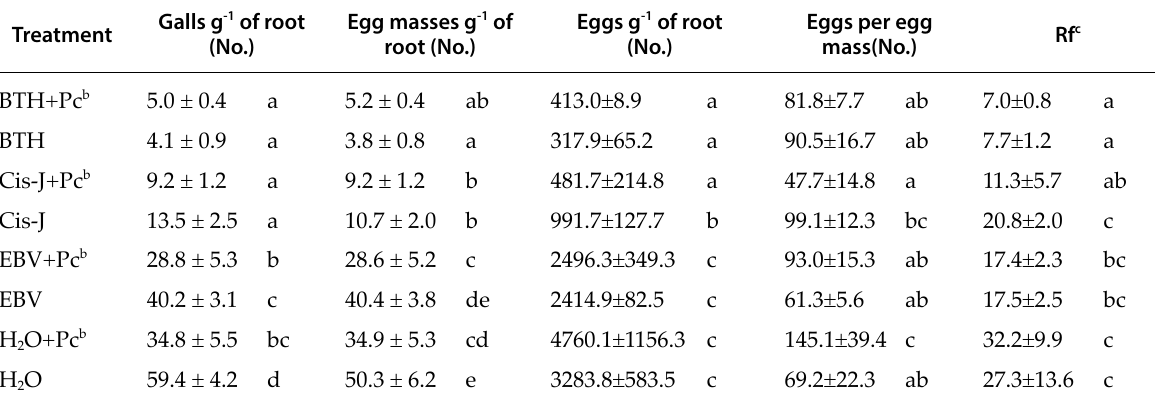
a Values are means of five replicates ± standard errors. Values followed by the same letter within a column are not significantly different according to LSD test ( P